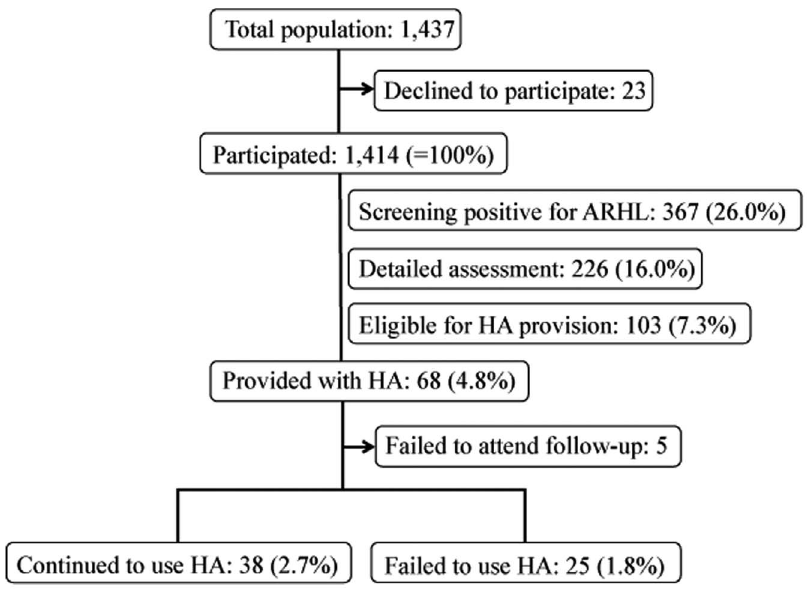
Figure 1. Procedure for the study along with the selection process, dropouts, and exclusions. ARHL = age-related hearing loss, HA = hearing aid.